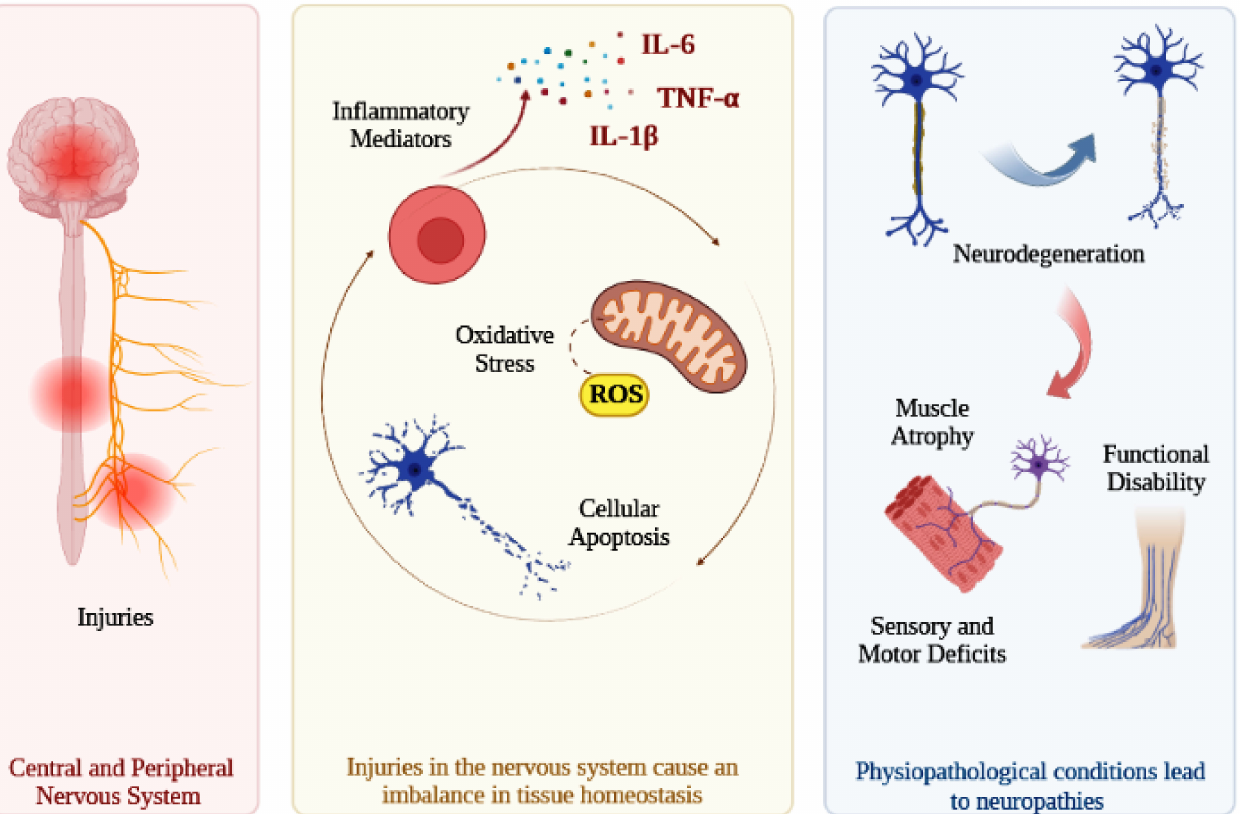
Figure 1. Injuries in the central or peripheral nervous system can lead to an increase in the synthesis of inflammatory cytokines, in the production of reactive oxygen species, and in cell apoptosis. These physiopathological alterations favor the degeneration of nervous cells, impair tissue regeneration, and compromise the recovery of neurological functions. Consequently, lesions in nervous tissue can cause complications of different degrees of severity, such as muscle atrophy, sensory and motor deficits, partial or total functional disability, and neuropathic pain. Interleukin-6 (IL-6); Tumor Necrosis Factor alpha (TNF- α ); Interleukin-1 beta (IL-1 β ); Reactive Oxygen Species